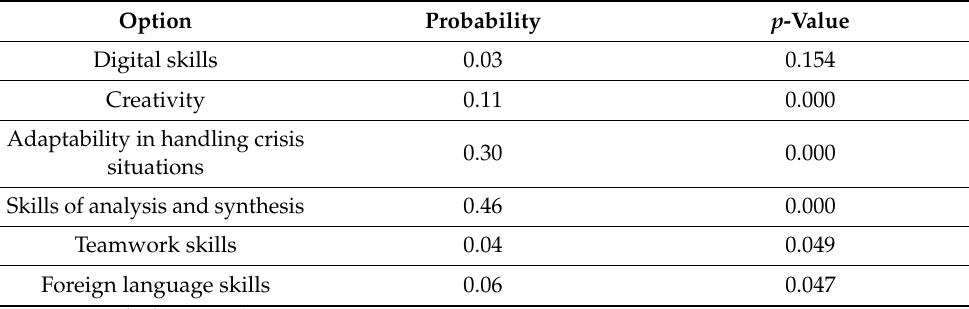
Table 4. Probabilities that students select a skill as the one that needs the highest improvement.